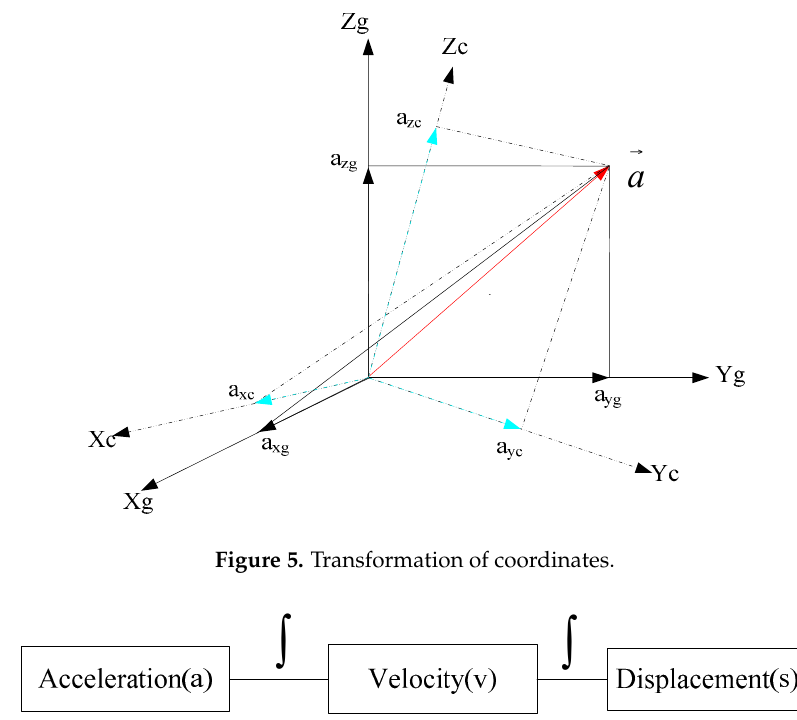
Figure 6. The diagram of changing acceleration to displacement.